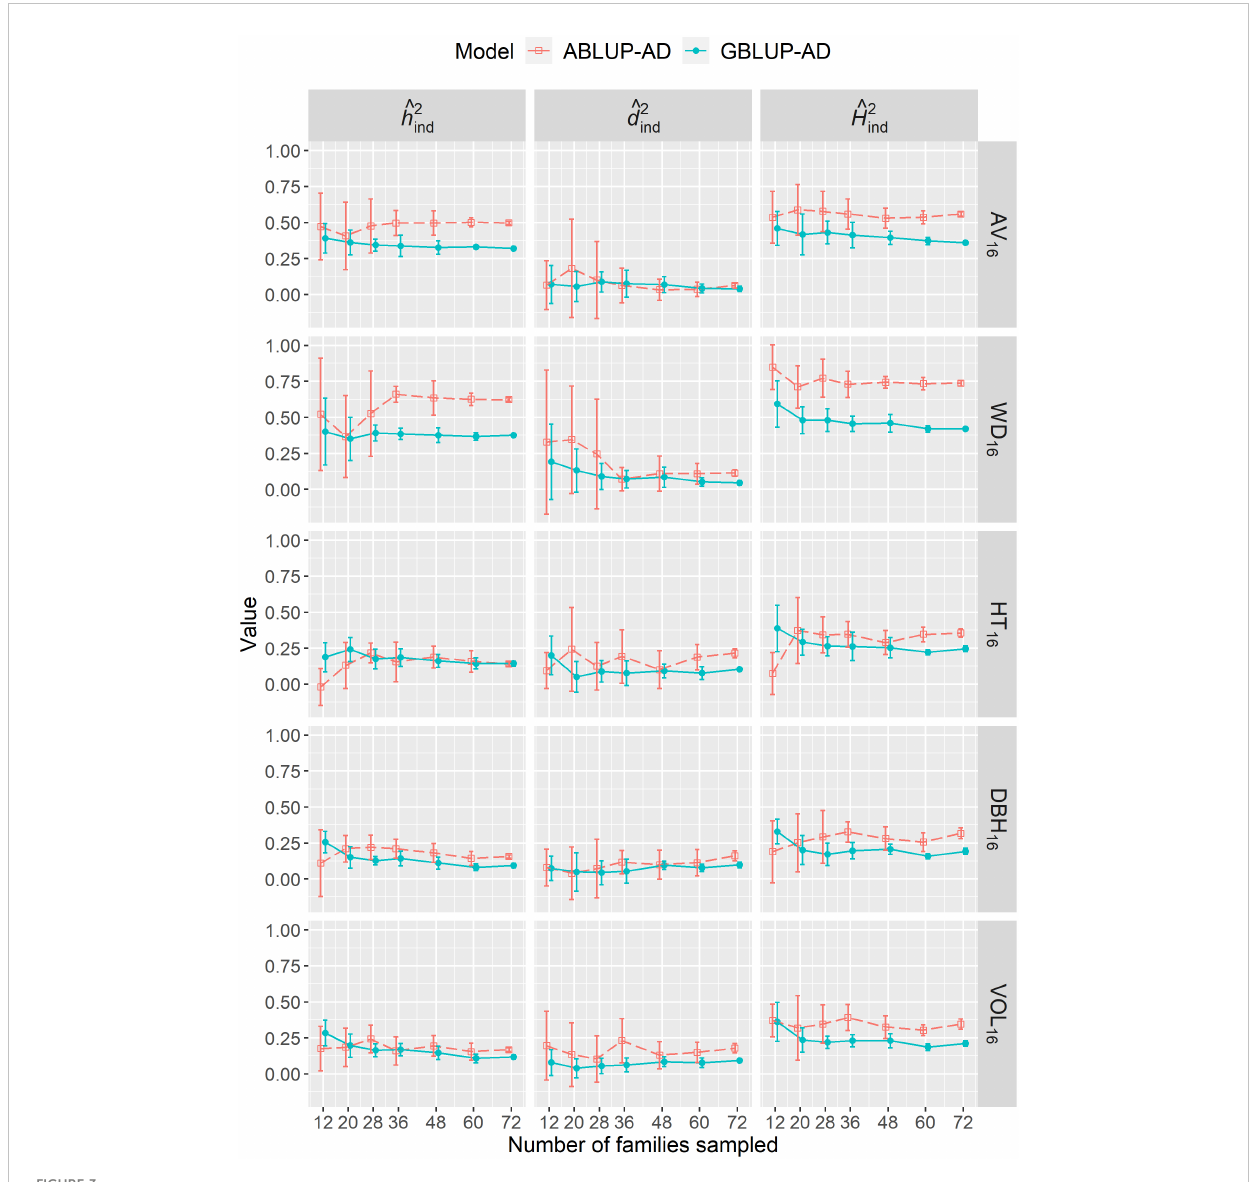
FIGURE 3 For dataset 1, across-site narrow-sense heritabilities ( ^ h 2 ind ), dominance ratios ( ^ d 2 ind ), and broad-sense heritabilities ( ^ H 2 ind ) estimated when varying the number of families sampled using the ABLUP-AD and GBLUP-AD additive-dominance models. The error bars represent the standard deviations of estimates across the 10 replications for each level of number of families sampled. See Table 2 for a description of